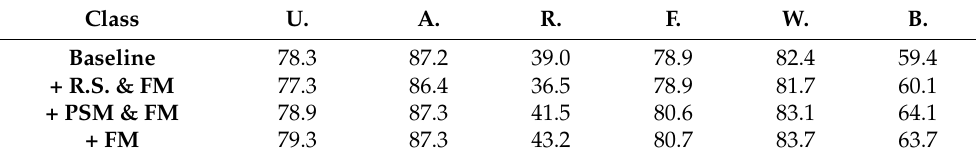
Table 7. Segmentation performance measured in IoU(%) on DeepGlobe.